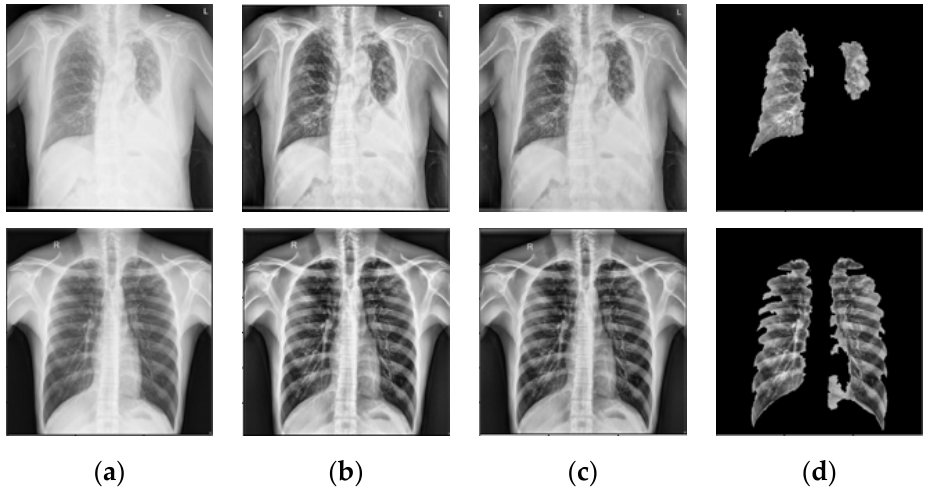
Figure 4. ( a ) Input Images—Abnormal; ( b ) Equalized images; ( c ) Weiner Filter; ( d ) Segmented images.